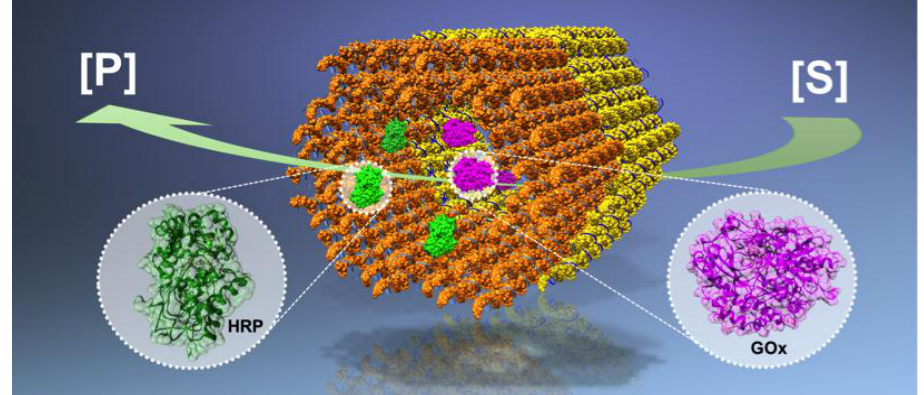
Figure 1. A schematic view of an enzymatic nanoreactor built from DNA ([S] = substrate, [P] = product). By taking advantage of the high addressability and modularity of the DNA nanostructures, enzymes can be attached and arranged with nanometer-scale precision. As an example, glucose oxidase (GOx, purple)–horseradish peroxidase (HRP, green) cascade pairs have been assembled into a confined reaction space provided by two tubular DNA origami nanostructures (orange and yellow cages).